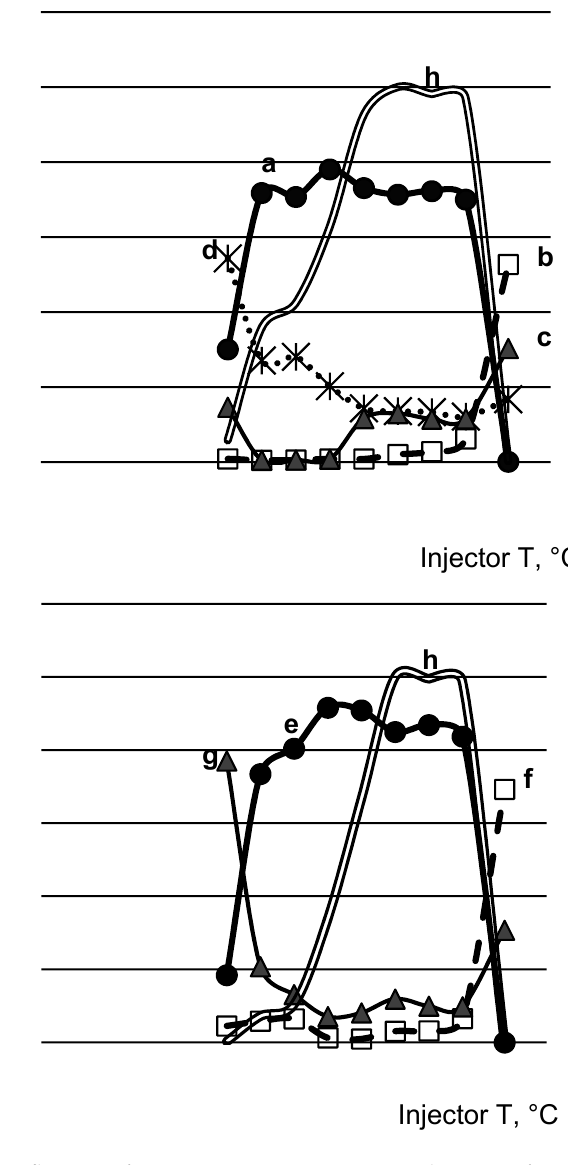
Figure 3. Influence of injector temperature on peak areas of atropine, scopolamine, and their main products of thermolysis, solvent methanol. Atropine ( a ), 3-phenylacetoxytropane (atropine-CH 2 O) ( b ), apoatropine (atropine-H 2 O) ( c ), tropine ( d ), scopolamine ( e ), 3-phenylacetoxyscopine (scopolamine-CH 2 O) ( f ), aposcopolamine (scopolamine-H 2 O) ( g ), sum of areas normalized to maximum value ( h ).